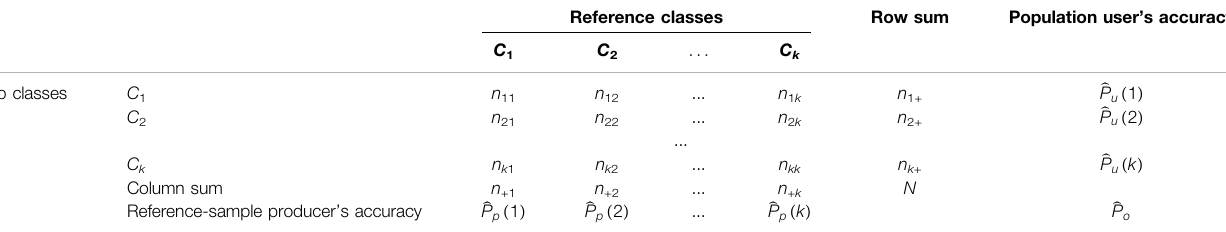
TABLE 2 | Reference sample confusion matrix for k -class land-use/land-cover classi fi cation using classi fi cation rules established using a training data set.